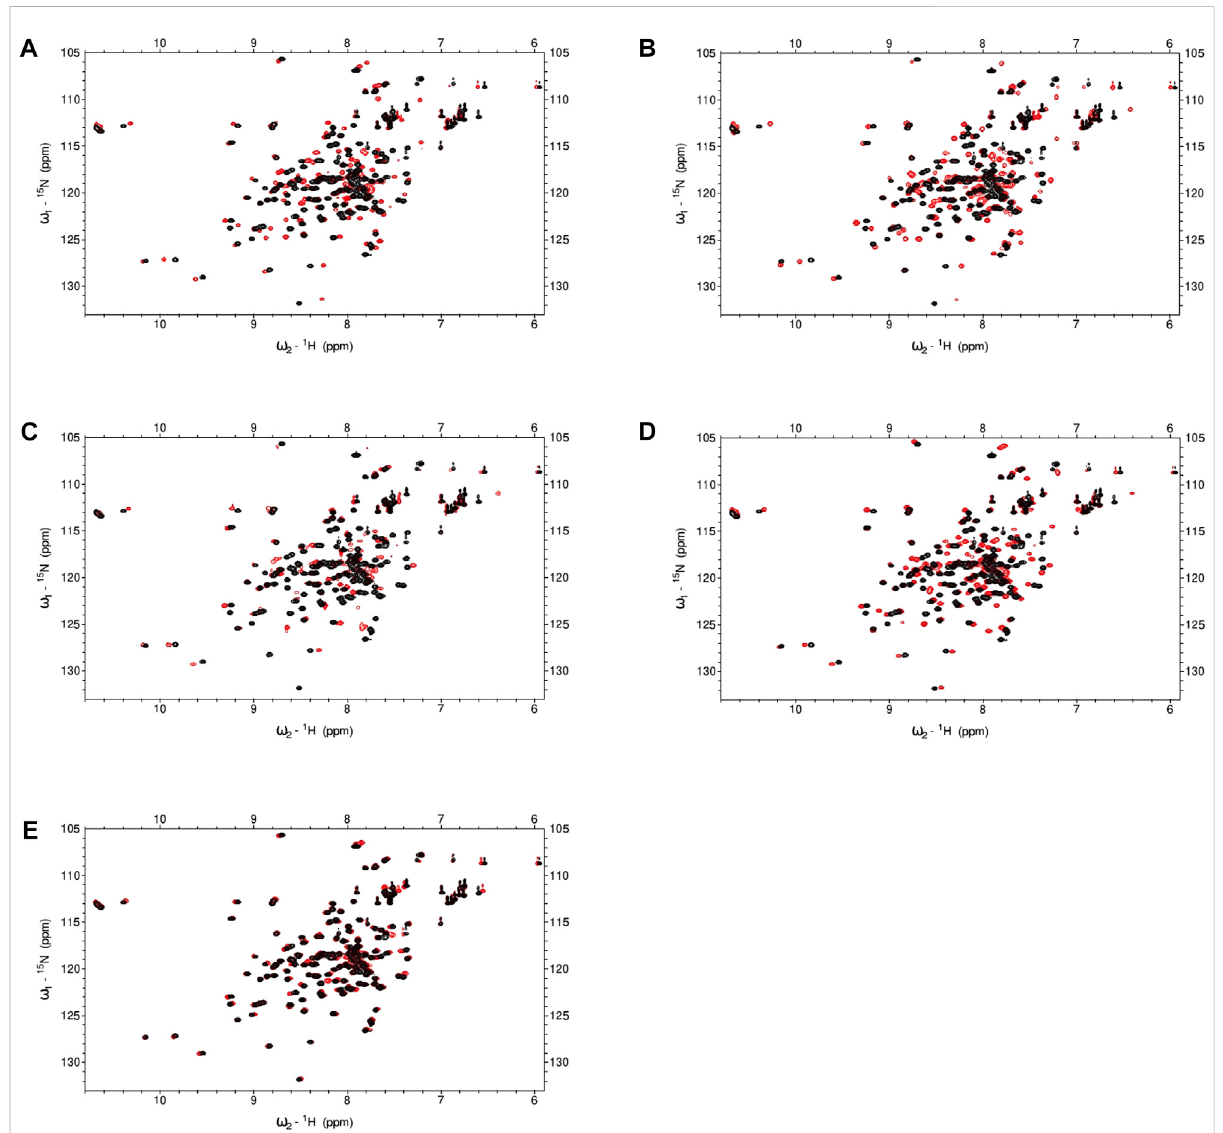
FIGURE 6 NMR spectra for CaM in the presence or absence of hit compounds. (A – E) 1 H, 15 N-HSQC for 100 μ M 15 N-CaM with 10 mM Ca 2+ in the absence or presence (red) of hit compounds at 5EQ molar excess over CaM. (A) Hit 12 (B) Hit 13 (C) Hit 15 (D) Hit 18 (E) Hit 21 . Buffer: 100 mM KCl, 20